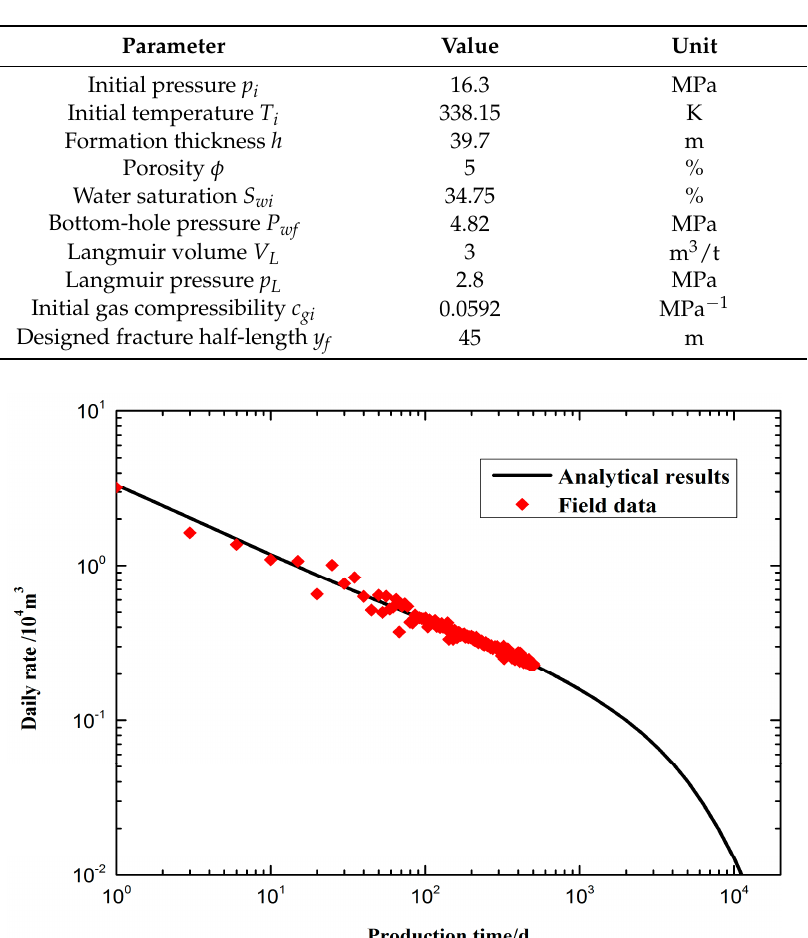
16 of 23 Figure 13. Effects of Langmuir pressure on pseudo-time variable λ ( t ). 4.4. Example Calculation In this paper, we attempt to apply the analytical solutions to the transient performance of a hydraulic fractured shale gas well in a Sichuan field. The daily rates from the early years have been used for plots. The available reservoir and fracture parameters are listed in Table 2. The gas flow rate is characterized by a decreasing trend for a long time. This indicates that the shale gas is produced with a constant bottom-hole pressure. Figure 14 depicts a log-log decline curve for the transient responses of this example well. The production data has been further applied in type-curve